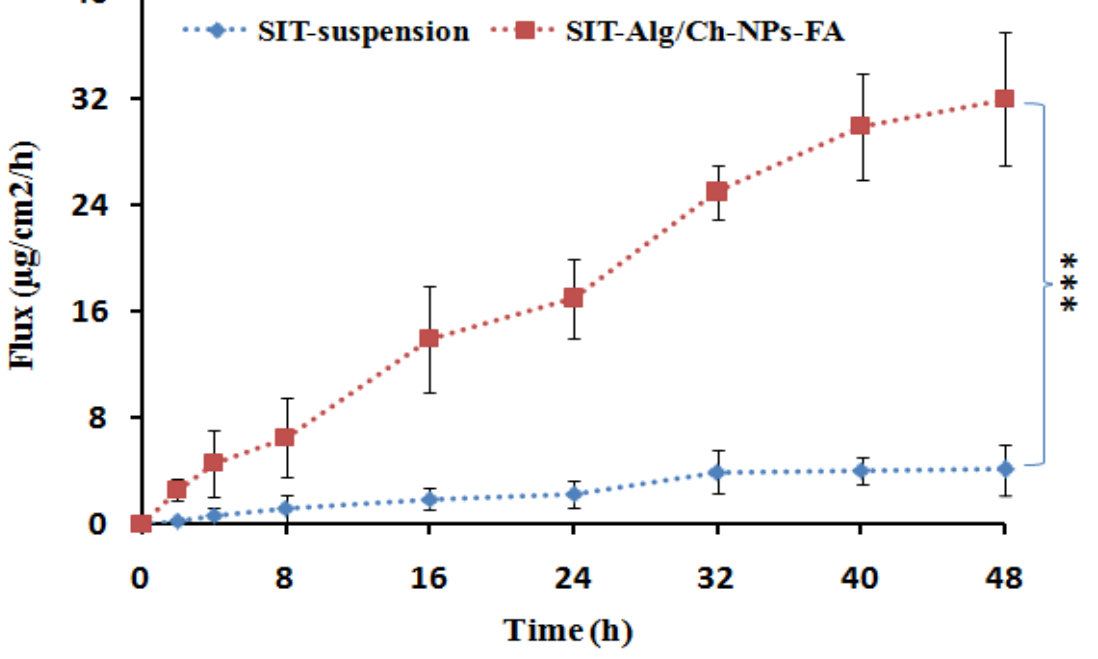
Figure 7. The flux of β -SIT-Alg/Ch-NPs-FA in comparison to β -SIT-suspension in ex vivo intestinal permeation study. Data expressed as mean ± SD ( n = 3) (*** p ≤ 0.001).